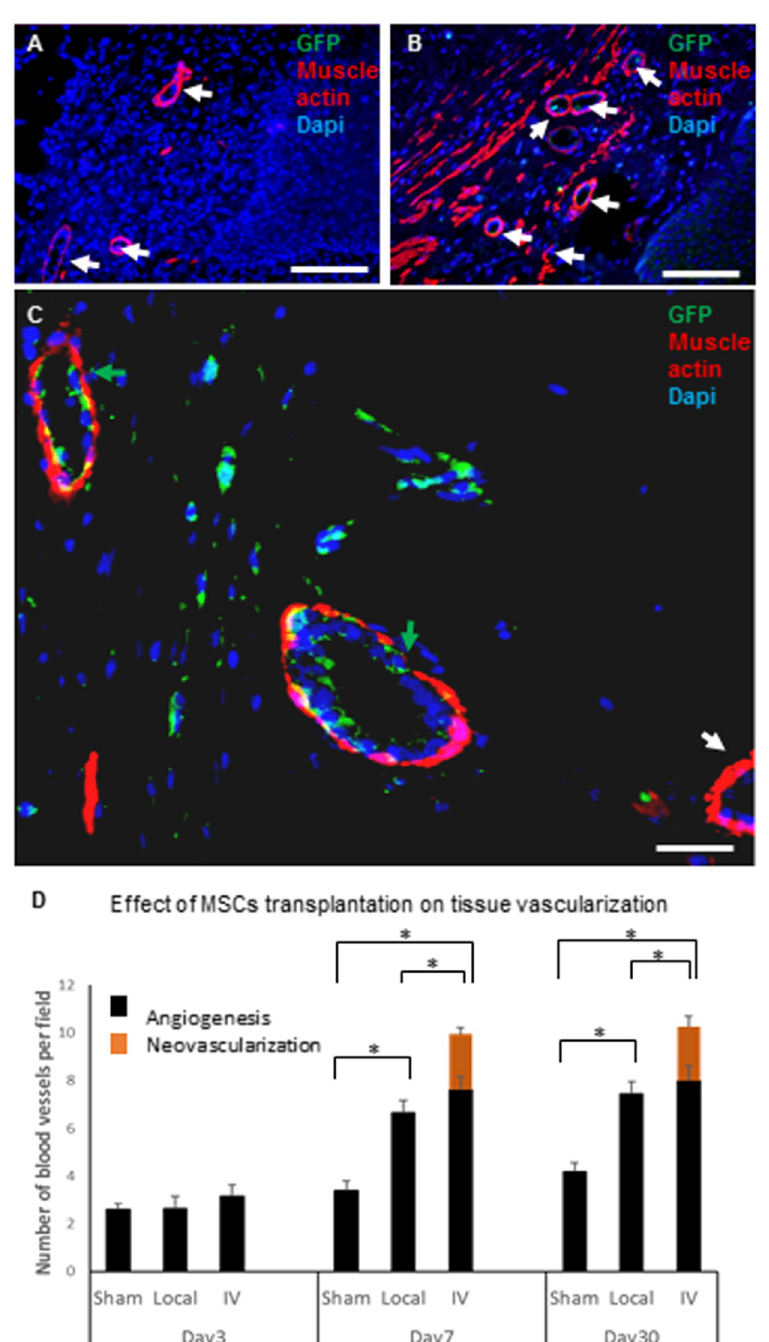
Fig 5. The effect of MSCs transplantation on tissue vascularization. To assess the effect of MSCs transplantation on tissue vascularization, vaginal sections from sham, local and I.V. transplanted rats were stained with anti-muscle actin and GFP antibodies. Representative images from day 7 of sham (A) and local (B) transplanted rats and of day 30 I.V. transplanted animals (C) are shown. The number of blood vessels without any staining to GFP (indicated with white arrows) per field at 10x magnification were analyzed (each group included five rats; three slides per rat; three fields were counted per slide). In addition, the number of blood vessels which had positive staining to GFP in the inner cell layer (green arrows) was analyzed. At days 7 and 30, MSCs transplantation induced angiogenesis (blood vessels without GFP) in both the local and systemically transplanted groups (D). Only in the systemically transplanted group, blood vessels composed of GFP-expressing cells, probably representing neovascularization involving the transplanted MSCs, were observed at 7 and 30 days post transplantation (C and D). � p < 0.05. Scale bar: A-B = 500 μ m; C = 50 μ m.